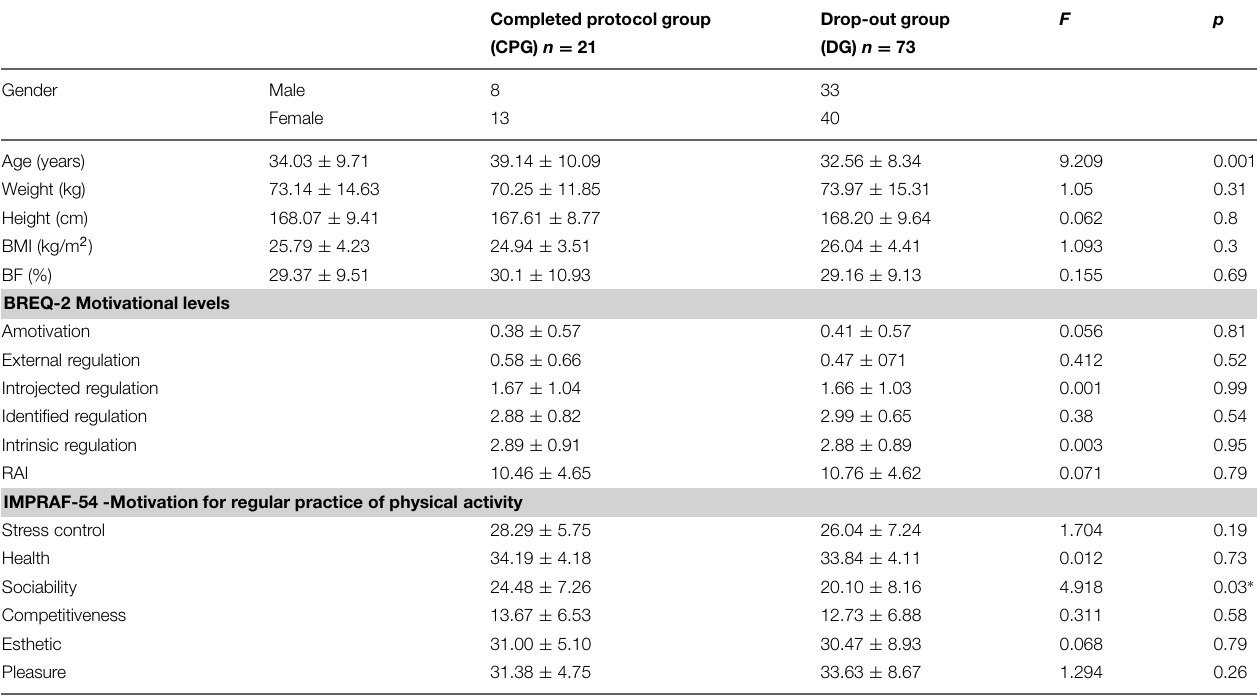
TABLE 1 | Characteristics of the 94 study participants (Mean ±